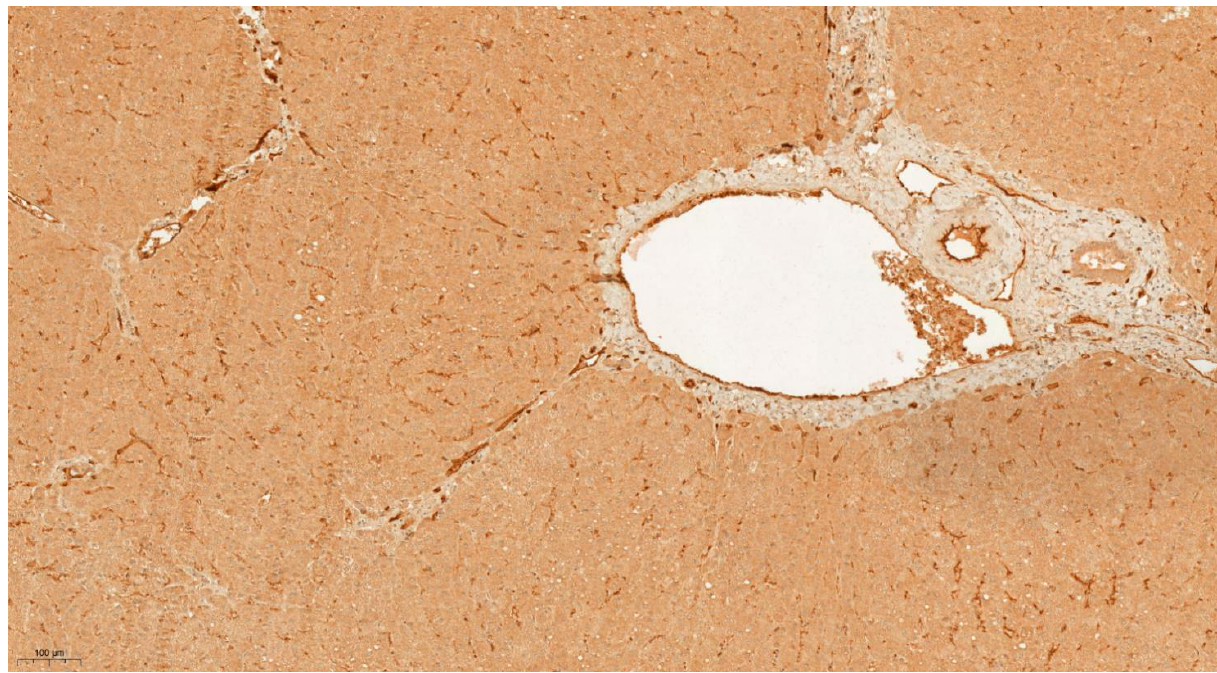
Figure 7. IHC characteristics of meprin A subunit a (MEP1A) in liver cirrhosis at low power magnification (X10). The brown chromogen should indicate protein expression of MEP1A in the nucleus and cytoplasm of the hepatic and stromal cells. The slide section of cirrhotic liver shows vague nodule formation with bridging fibrosis; staining for MEP1A here was negative (Allred score 0).